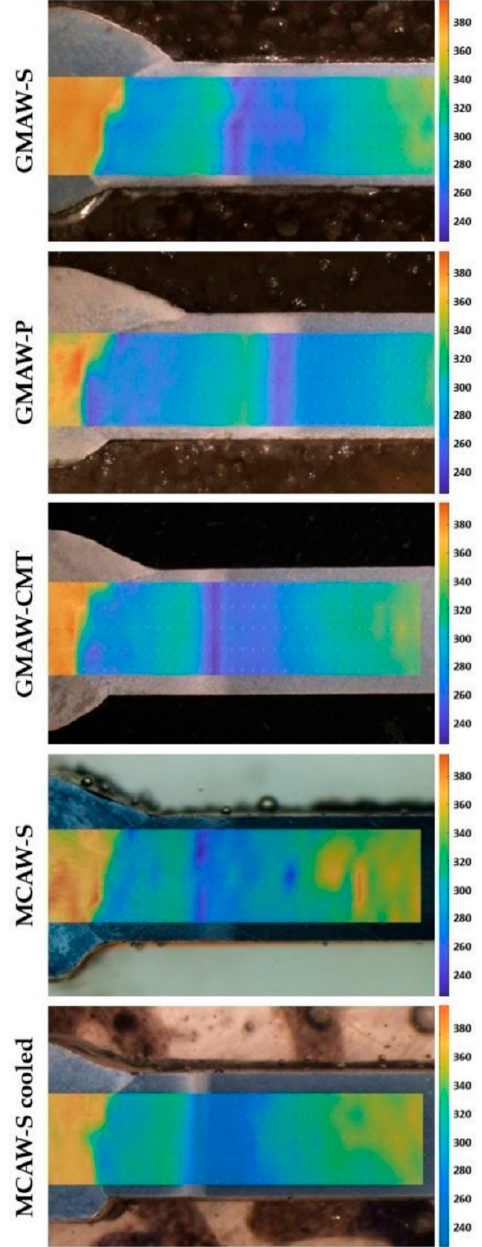
Figure 6. Hardness distribution in the heat-affected zone (HAZ) of the assessed welded joints.